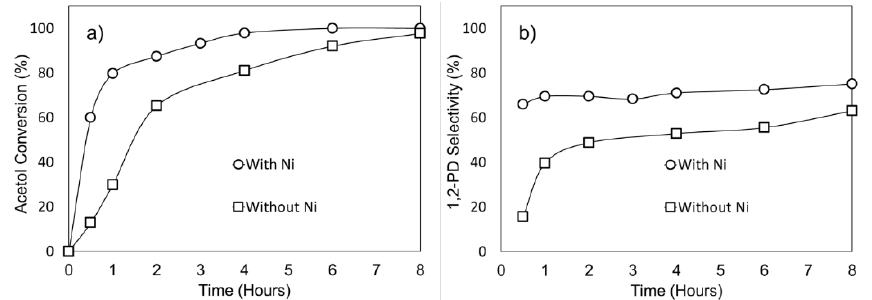
Figure 11. Promoting e ff ect of Ni on Cu / ZnO / Al 2 O 3 -OA for acetol hydrogenation: ( a ) acetol conversion; ( b ) 1,2-PD selectivity. Conditions: 200 ◦ C, 500 RPM, 100 g feedstock mixture, 20 wt% aqueous acetol, 1 g catalyst, H 2 pressure 2.8 PMa. With Ni: Ni / Cu / Zn / Al (molar) = 5 / 32.5 / 32.5 / 30, without Ni: Cu / Zn / Al = 35 / 35 / 30. Table 6. Promoting e ff ect of Ni on Cu / ZnO / Al 2 O 3 -OA for acetol hydrogenation 1 . Acetol 1,2-PD 1,2-PD Others Rate Constant Catalysts Conversion Selectivity Yield Yield (s − 1 ) Cu / ZnO / Al 2 O 3 -OA 2 97.7 63.1 61.6 36.1 1.231 × 10 − 4 5% Ni / Cu / ZnO / Al 2 O 3 -OA 3 100.0 75.1 75.1 24.9 2.721 × 10 − 4